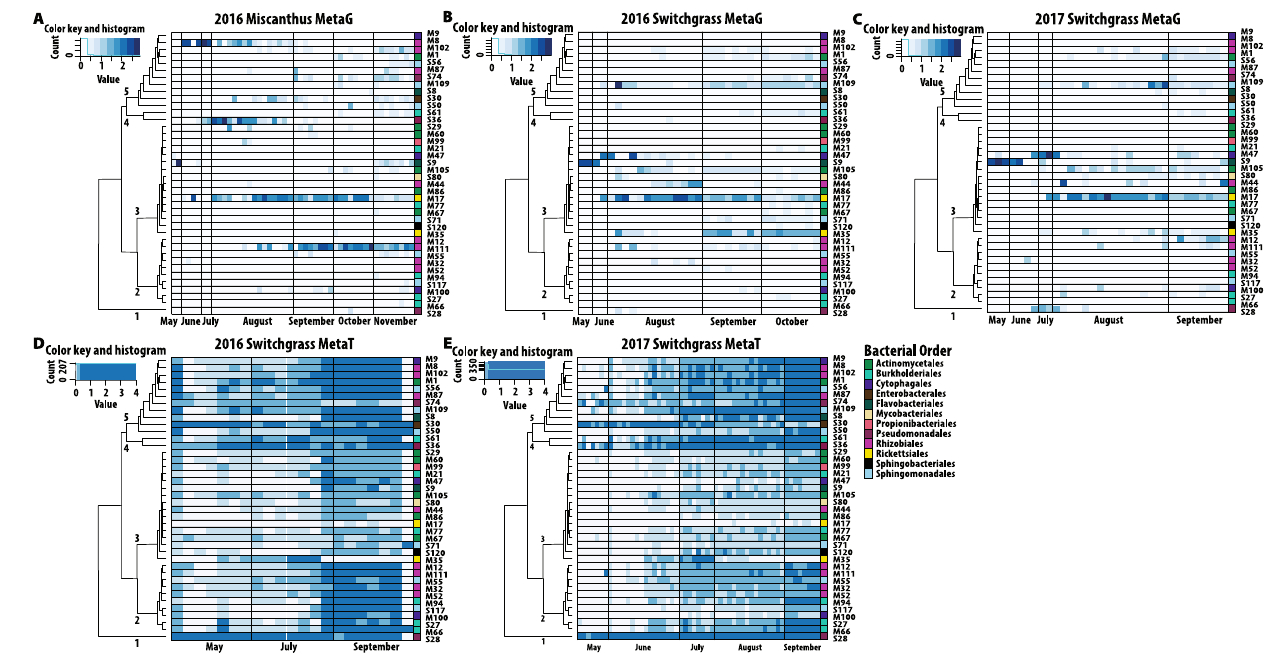
Fig. 4 | Seasonal patterns of the 40 focal MAG metagenome and metatran- scriptome read recruitment. Abundance is indicated by color intensity, with blue indicating high and white indicating low abundance. MAG abundances for: A Miscanthus 2016 metagenomes (metaG); B Switchgrass 2016 metagenomes; C Switchgrass 2017 metagenomes; D Switchgrass 2016 metatranscriptomes (metaT)and E Switchgrass 2017metatranscriptomes. Abundances of metagenome contigs were estimated with the median base pair of read recruitment divided by